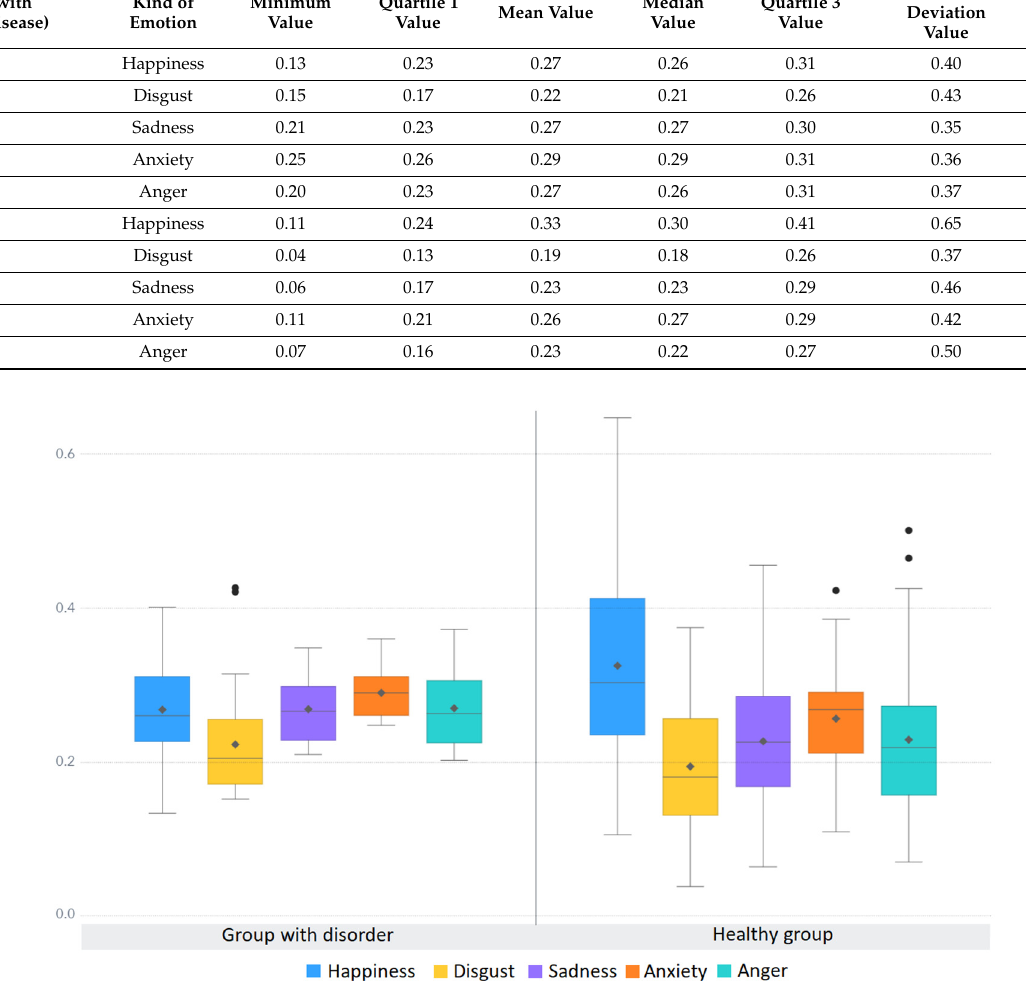
Figure 6. Distribution of emotions within group of people with disorder and healthy people.